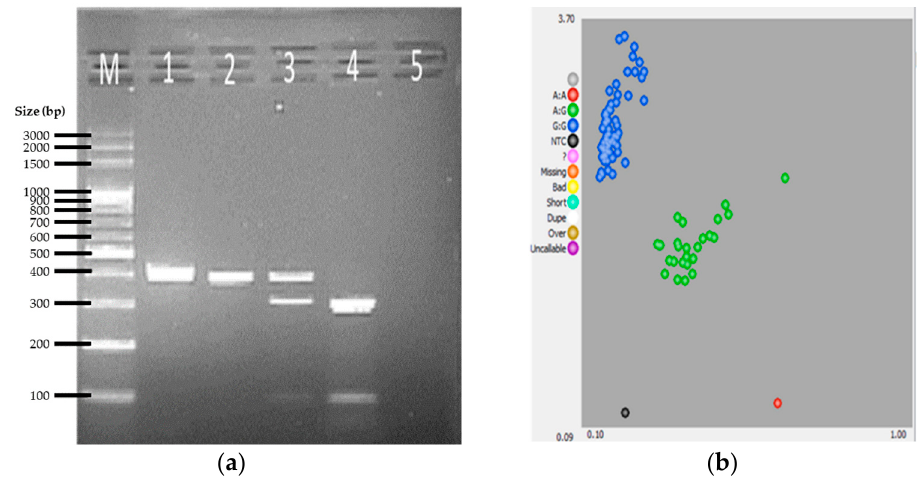
Figure 1. Representative results for LDHA gene SNP genotyping by PCR-RFLP and KASP assays. ( a ) Agarose gel electrophoretic profile of selected samples showing the banding patterns for the undigested PCR amplicon (lane 1), the LDHA AA allele (lane 2), LDHA AG allele (lane 3), and LDHA GG allele. ( b ) Cluster plot for the KASP genotyping assay: LDHA AA allele (red cluster), LDHA AG allele (green cluster), and LDHA GG allele (blue cluster).